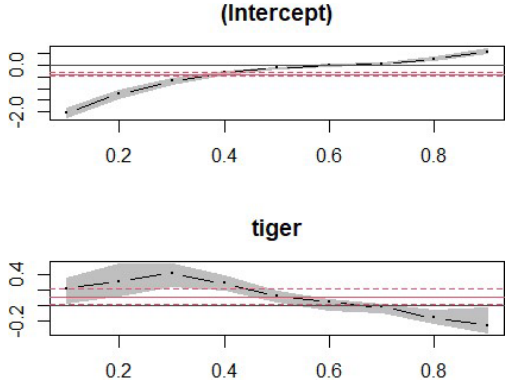
Figure B3. Slopes of quantile regression of effects on tiger density on leopard density where leopard density declines in higher quan- tiles.